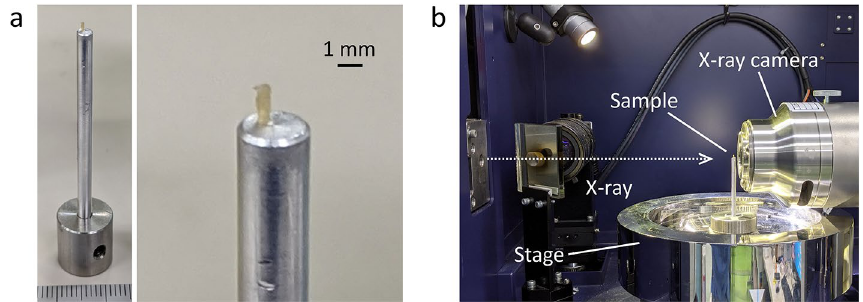
Figure 2. Experiment setup of laboratory-based X-ray microscopy. ( a ) Photograph of direct-mounted kidney sample. Entire image (left) and magnified part around the sample (right) are shown. ( b ) Configuration of X-ray scanning. Representative parts of the apparatus are labeled with